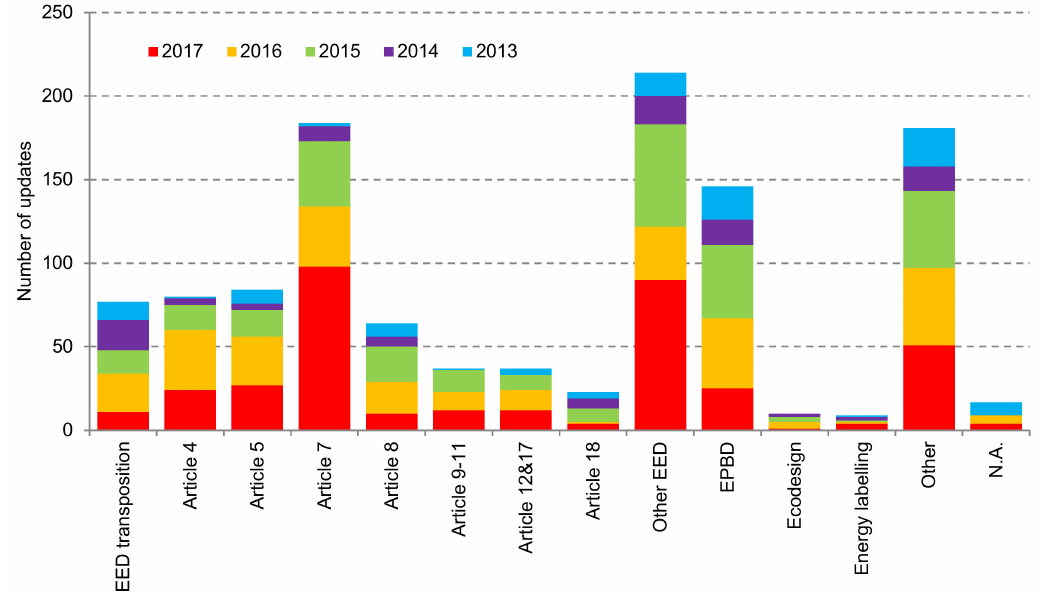
Figure 1. Policy updates by legal basis from 2013 to 2017 reported in the Annual Reports.